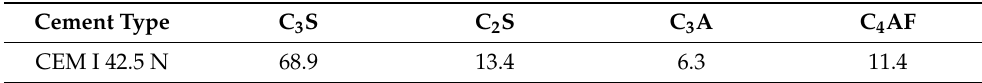
Table 2. Mineralogical composition of Portland